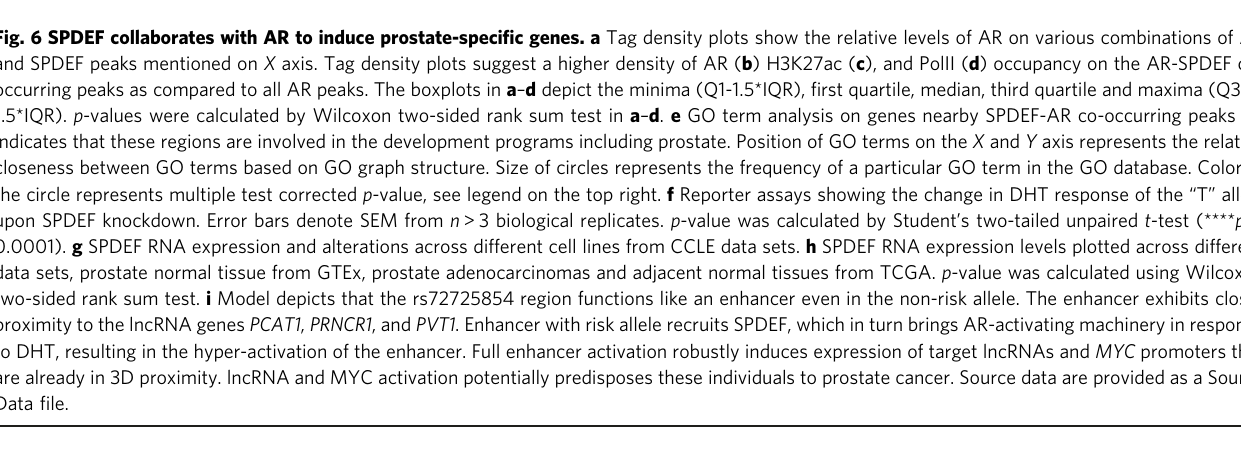
Methods Cell culture and treatment . LNCaP, 293FT, and MCF7 cell lines were obtained from the American Type Culture Collection (ATCC). The cells were cultured in lines by MycoAlert, Mycoplasma Detection kit (LT07-118, Lonza). For DHT response, LNCaP cells were serum starved for 72h in Stripping medium (RPMI without phenol red with 10% charcoal stripped FBS and 1% Pen – Strep) including 16h of stimulation with DHT (10 nM) (Sigma Inc.). Antibodies . SPDEF (sc-166846, Santacruz Biotechnology), FLAG (F7425, Sigma), H3K27ac (ab4729, Abcam), H3K9me3 (39161, Active Motif), and GAPDH (sc- 32233, Santacruz Biotechnology) antibodies were obtained from respective manufacturers.